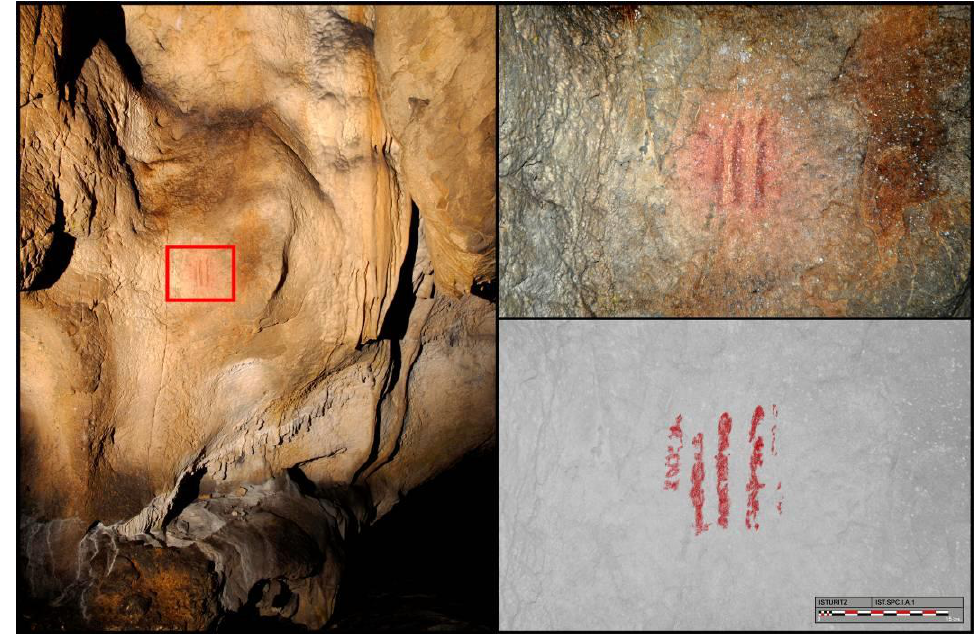
Figure 8. Vertical lines in the Sepulchral hall of the Saint-Martin Hall.